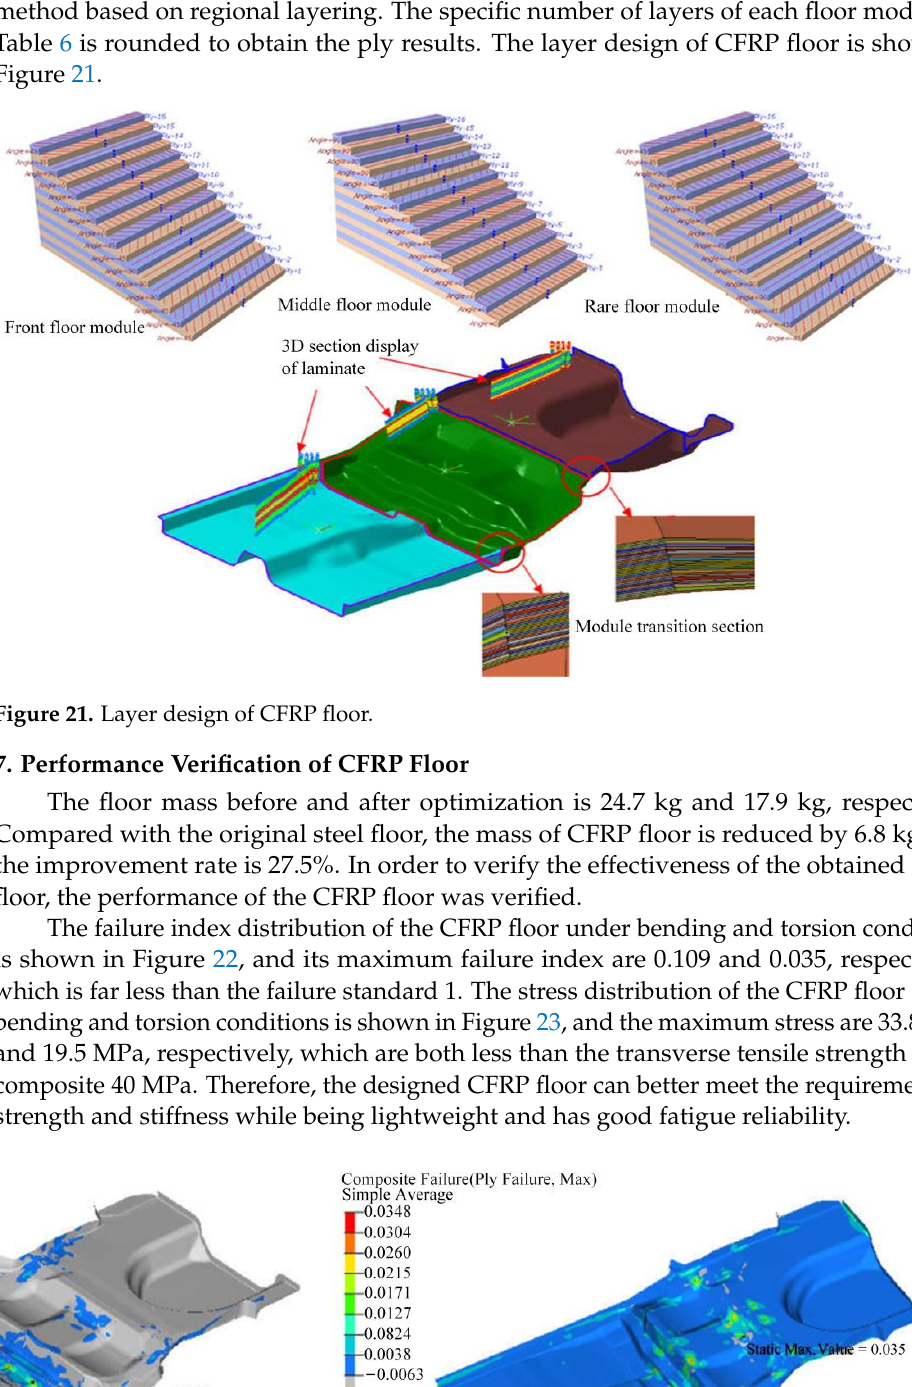
( b ) Figure 23. Stress distribution of composite floor: ( a ) Bending condition; ( b ) Torsional condition. 8. Conclusions In this article, the basic theory of composite mechanics is expounded from the stress-strain theory of single-layer plates, the stiffness and strength theory of laminate, which provides an important theoretical support for the structural design, material de- sign and allowable value design of composite materials. And the Tsai-Wu strength theo- ry is selected as the strength criterion of the CFRP floor laminates. Through the mechan- ical property tests of CFRP T300/5208 and Araldite 2015 structural adhesive, the basic material parameters were obtained for structural simulation analysis and optimization of the CFRP floor. The integrated design of the front, middle, and rear floor of the automobile is car- ried out by using the integrated design characteristics of composites. The shape of the floor super layers is optimized by using the free size optimization method with the BIW lightweight coefficient as the objective and the BIW performance as the constraints. The BIW lightweight coefficient is reduced from 4.35 to 4.20 after free size optimization, and the layer blocks shape are obtained and clipped based on engineering application. With the floor mass as the objective, and the BIW performance as the constraints, the size op- timization of the floor layer blocks thickness is optimized. Finally, the number of floor layers are obtained, and the CFRP floor is established in Fibersim software. A simulation analysis method is then used to compare and verify the performance of the floor before and after optimization. The mass before and after optimization is 24.7 kg and 17.9 kg, respectively. Compared with the original steel floor, the mass of CFRP floor is reduced by 6.8 kg, and the improvement rate is 27.5%. And the failure index of the floor is far less than the failure standard 1. The results show that the design and op-